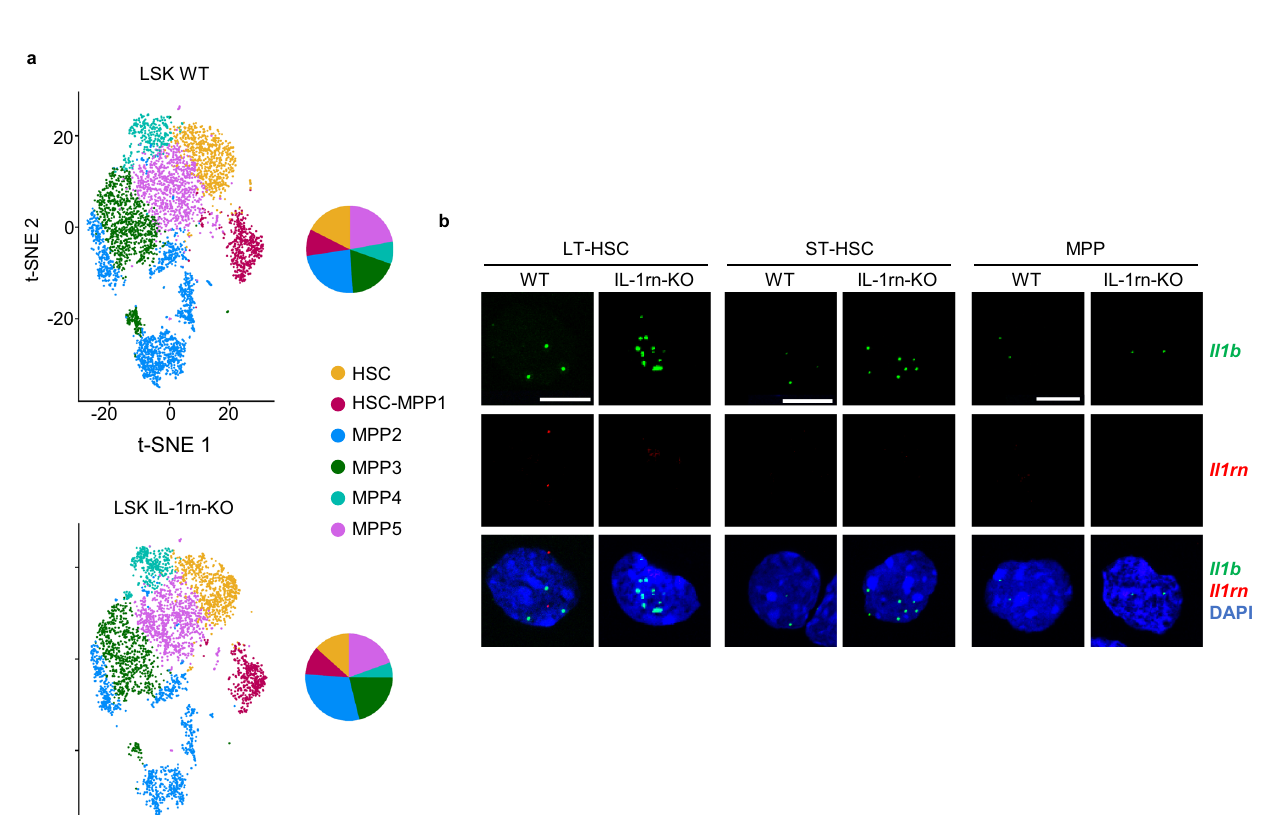
Fig. 5 | Identi fi cation of the sources of IL-1 β and IL-1rn in the bone marrow at the single-cell level within the myeloid compartment. a – c Single-cell RNA sequencing in bone marrow (BM) CD11b + myeloid cells from C57BL/6J wild-type (WT, n =1samplefrom2biologicallyindependentanimals)andIL-1rnknockout(IL- 1rn-KO, n =1 sample from 2 biologically independent animals) mice. a t-SNE plots visualizing colored cluster assignment annotated with the Immgen database fol- lowed by scoring of gene signatures imported from GSE137539 dataset over neutrophil-like subsets and those imported from GSE131834 dataset over monocyte-likeclusters.Clusterassignmenttoeachcelltypewasobtainedusingthe maximumenrichment score ±0.2 and subsequent manual curation. Piecharts with